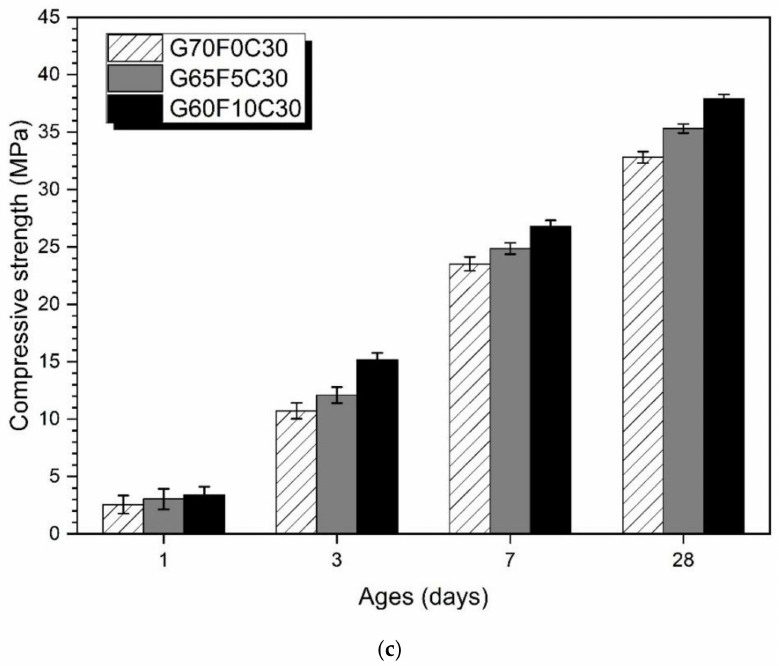
Figure 2. Compressive strengths of slag-SF-CSAe cement pastes, ( a ) 10% CSAe samples, ( b ) 20% CSAe samples, and ( c ) 30% CSAe